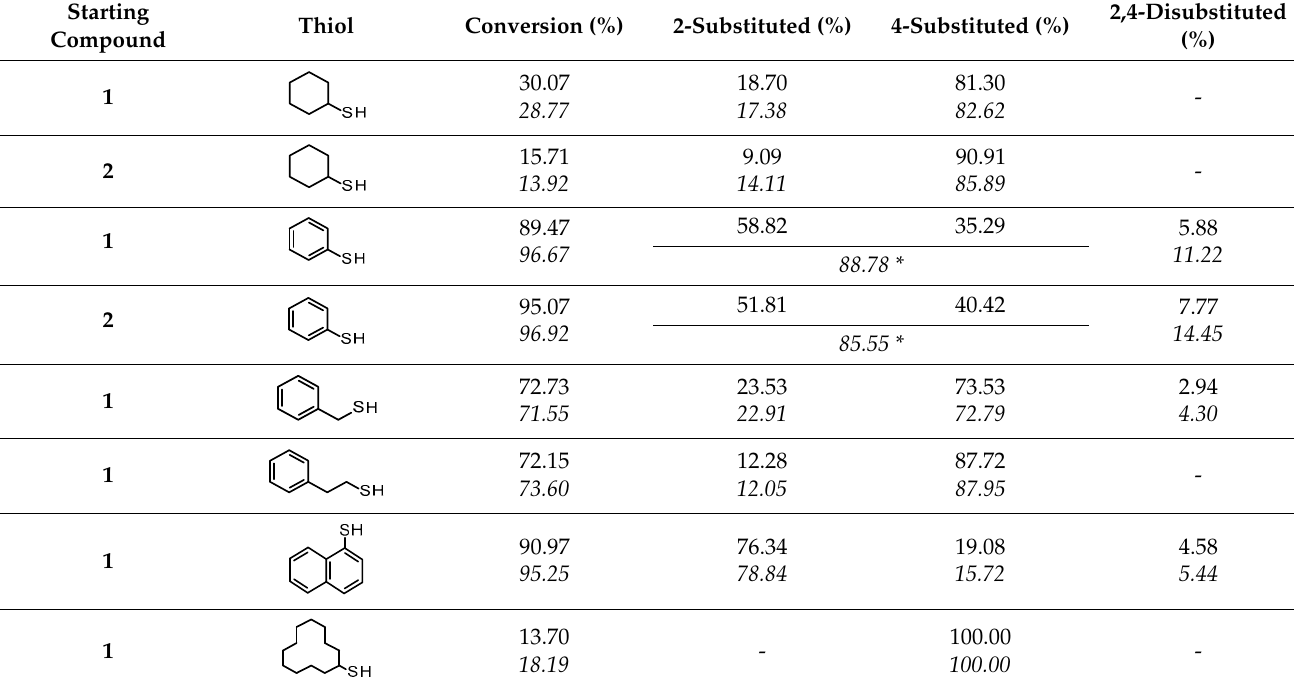
Scheme 1. The synthesis of methyl halo 2- and 4-substituted-5-sulfamoyl-benzoates: (i) TEA, DMSO, 60 °C; (ii) K 2 CO 3 , DMSO, 60 °C; (iii) TEA, MeOH, Δ ; (iv) H 2 O 2 , AcOH, 75 °C. The legend in the middle explains the structures of alkyl (Ak; b , c , d , e ) and aromatic (Ar; a , f ) substituents and halo- gen atoms (Cl—compounds 1 , 3 , 5 , 7 , 9 or Br— 2 , 4 , 6 , 8 , 10 ). The regioselectivity of the nucleophilic aromatic substitution of a halogen in methyl 2,4-dihalo-5-sulfamoyl-benzoates 1 , 2 was investigated. All reactions were repeatedly per- formed in DMSO with triethylamine at 60 °C temperature for 72 h. Determination of con- version yield, product ratio, and structure identification has been performed by NMR and HPLC/UV/MS (Table 1, and Supplementary material). Table 1. The reaction of 2,4-dihalo-5-sulfamoyl-benzoates 1 , 2 with thiols and the ratios of the prod- ucts as determined by NMR spectroscopy and HPLC/UV/MS system data ( italic ). * The separation of the 2- and 4-substituted isomers formed in the reaction of compounds 1 and 2 with phenylthiol using HPLC was unsuccessful.